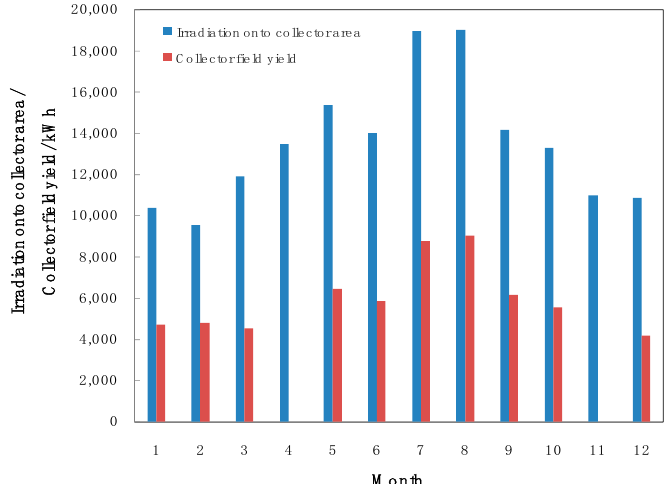
Energies 2019 , 12 , x FOR PEER REVIEW Figure 10. The monthly solar irradiation onto the collector area and the collector filed yield in 2018.